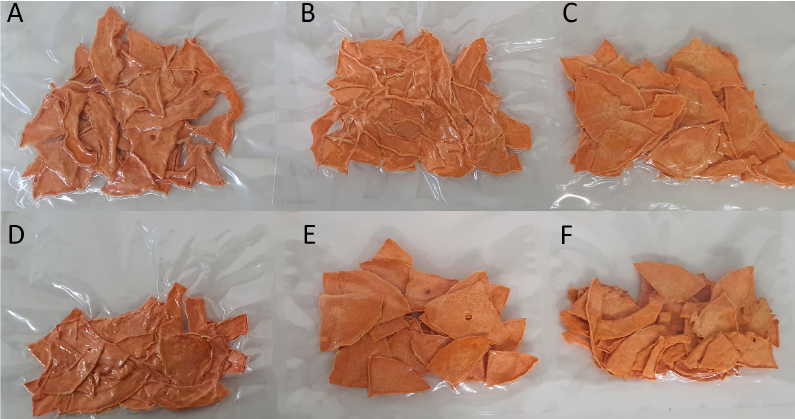
Figure 3. Dried pumpkin slices. ( A – C )—30% amplitude, 30, 45 and 60 min processing time; ( D – F )—90% amplitude, 30, 45 and 60 min, respectively. Table 5. Relationship between ultrasonic parameters and color change in samples. US Power/% Sonication Time/min